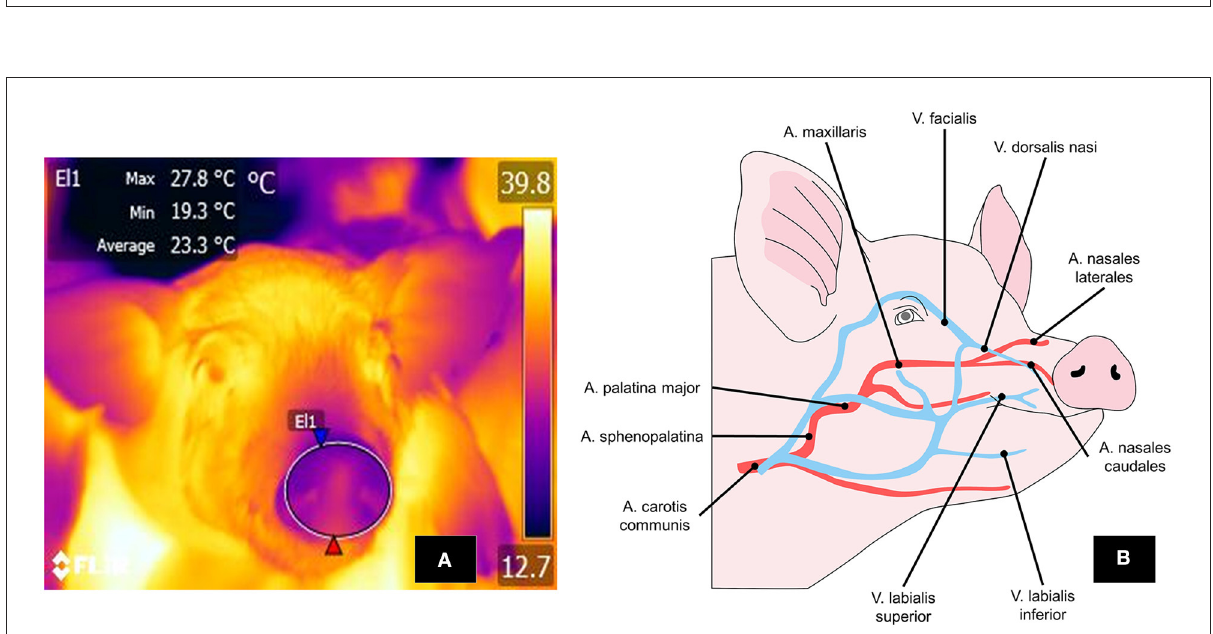
FIGURE7 Thermal nasal window. (A) To mark the perinasal window, a large circle is drawn around the entire snout with the upper lip as its ventral limit. (B) The nasal region and vasomotor changes there depend on circulation through the lateral and caudal nasal arteries and the dorsalis nasi vein, a branch of the facialis vein. These structures respond with vasodilation or vasoconstriction, according to the stimulus